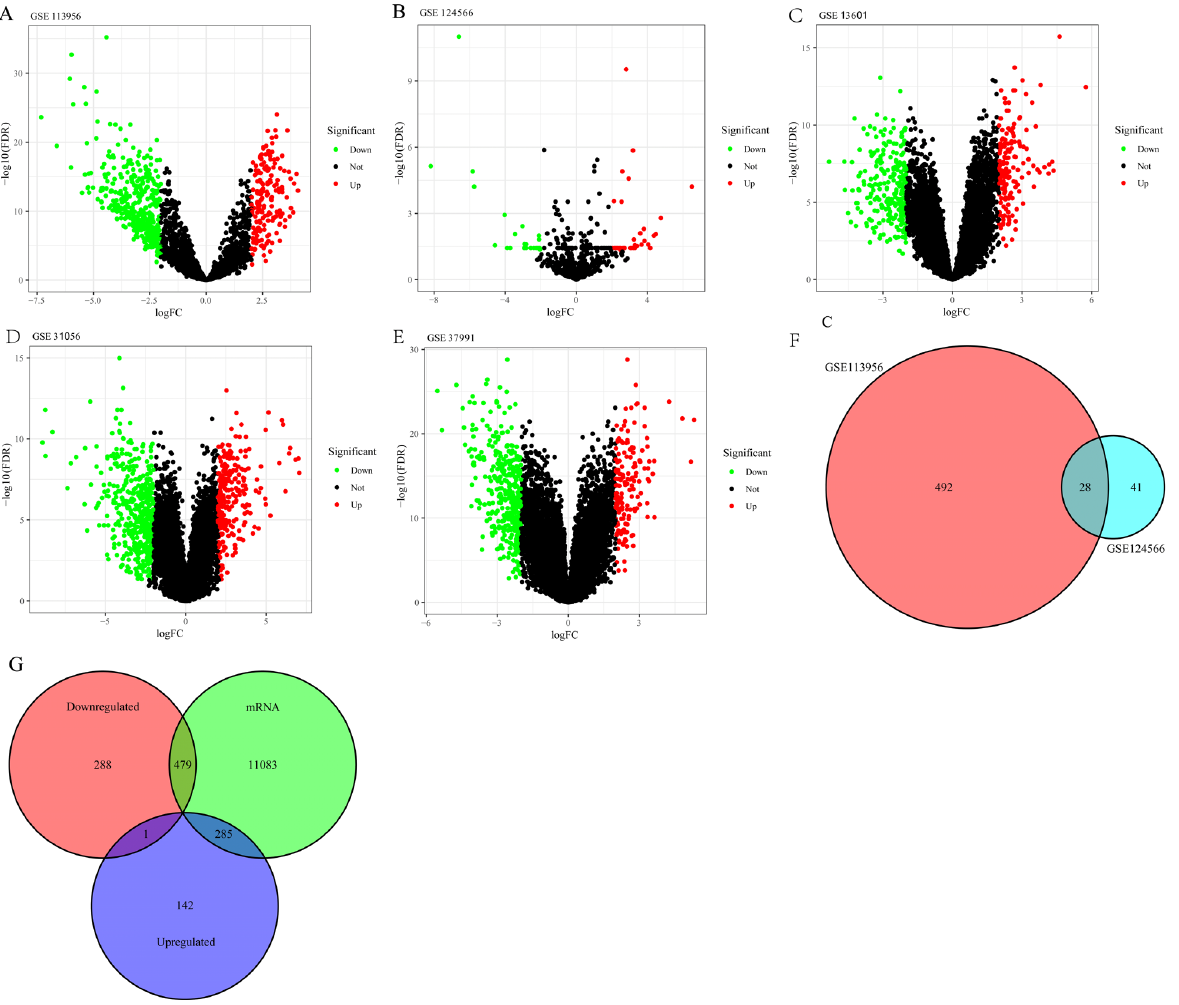
Fig. 2. Screening for differentially expressed miRNAs (DEMs) and genes (DEGs). Expression volcano map of GSE113956(A), GSE124566(B), GSE13601(C), GSE31056(D) and GSE37991(E). Red dots represented up-regulation, green dots represented down-regulation, and black dots represented no significant changes in expression levels. P (FDR)<0.05 and |log FC|>2. (F) 28 DEMs were screened out. (G) 285 up-regulated DEGs and 479 down-regulated DEGs were screened